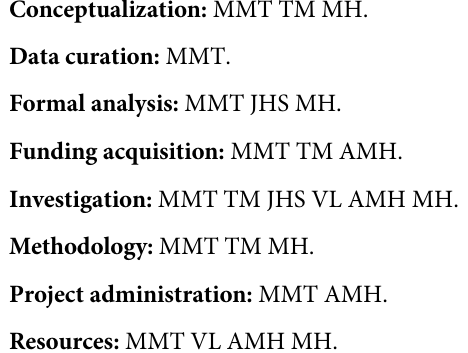
S2 Table. Pairwise F values between 42 population samples of Fraxinus excelsior based ST on six nuclear microsatellite loci. S3 Table. Results from the bottleneck test. The Wilcoxon test was used under the infinite allele model (IAM), two phase model (TPM) and the stepwise mutation model (SMM). S4 Table. Genotypes at six nuclear microsatellite loci for 42 Fraxinus excelsior populations. S5 Table. Overview of the nature reserves and the contact persons at the County Governors nature management authorities who issued the permission to collect Fraxinus excelsior in the different locations. S1 Fig. Map showing the locations and abbreviated names of the 42 analysed Fraxinus excelsior